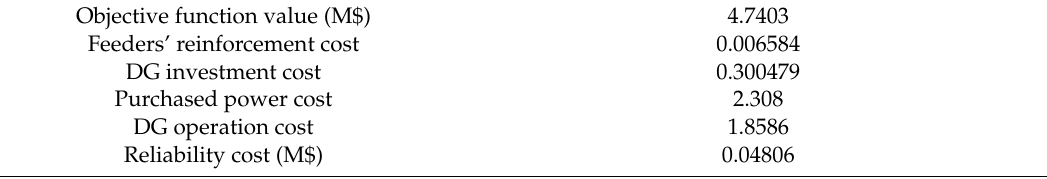
Table 4. The results of the best solution based on the proposed